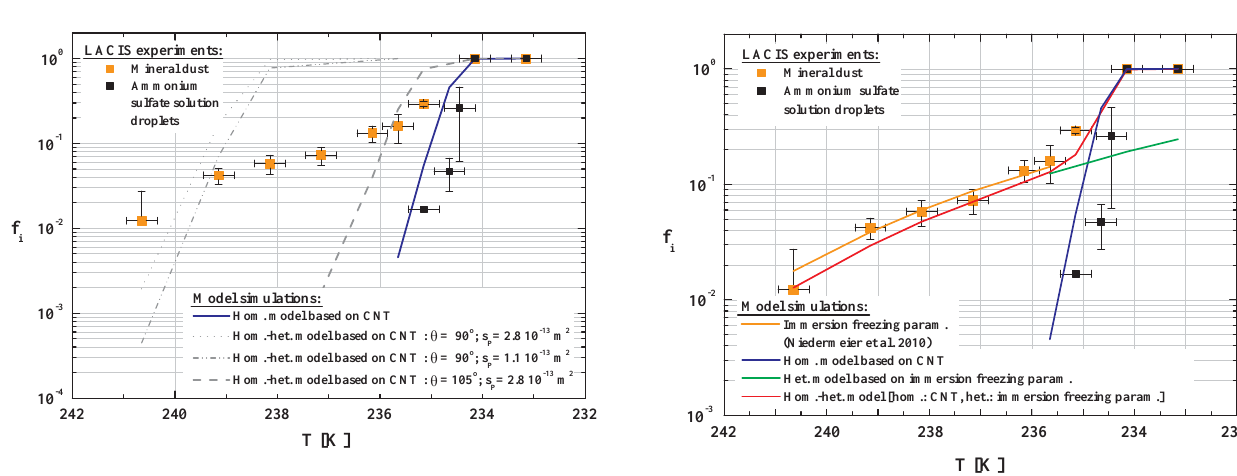
Fig. 17. Comparison of LACIS experiments (freezing of droplets Fig. 7. Comparison of LACIS experiments (freezing of droplets containing 300 nmmineraldustparticlesactingasIN:orangecubes containing 300nm mineral dust particles acting as IN: orange cubes and freezing of highly dilutes ammonium sulfate solution droplets: blackcubes)withFluent/FPMmodelsimulationresults. Theorange and freezing of highly dilutes ammonium sulfate solution droplets: line represents the immersion freezing parameterization derived in black cubes) with Fluent/FPM model simulation results. The or- (Niedermeier et al., 2010). The model simulations applying either ange line represents the immersion freezing parameterization de- homogeneous ice nucleation according to CNT (blue line), or het- erogeneous ice nucleation based on the immersion freezing param- rived in Niedermeier et al. (2010). The model simulations applying eterization derived in (Niedermeier et al., 2010) (green line) or the either homogeneous ice nucleation according to CNT (blue line), or combination of both (red line). heterogeneous ice nucleation based on the immersion freezing pa- rameterization derived in Niedermeier et al. (2010) (green line) or the combination of both (red